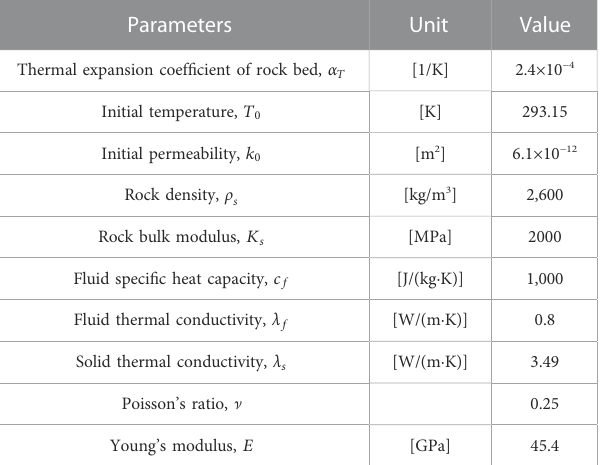
Thermal fi eld boundary conditions: the inlet boundary is set as the temperature boundary, the outlet boundary is set as the out fl ow boundary, and the rest are thermally insulated.